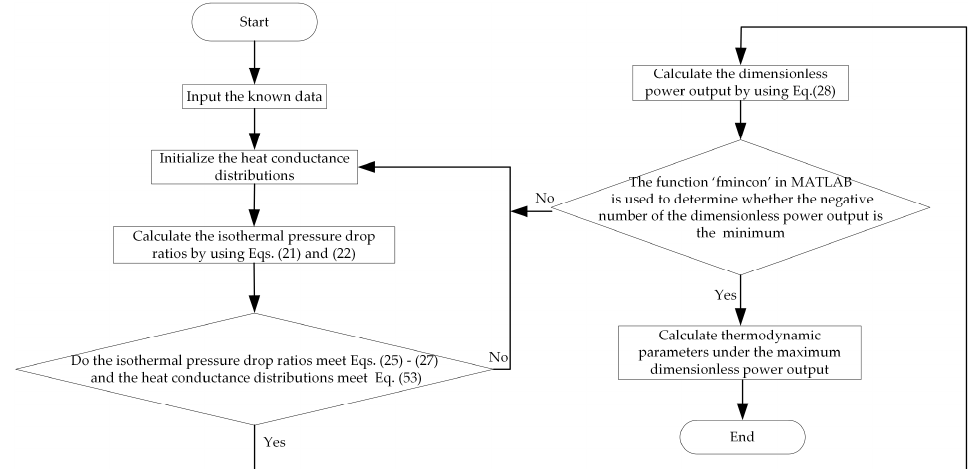
Energies 2020 , 13 x FOR PEER REVIEW 10 of 21 Figure 2. Flow chart of dimensionless power output (PO) optimization. Figure 2. Flow chart of dimensionless power output (PO) optimization. When Figure 3a,b, Figure 4a,b, Figure 5a,b and Figure 6 illustrate the relationships of the maximum dimensionless PO ( W max ), the corresponding dimensionless PO ( W top ) of the topping cycle, W max dimensionless PO ( W bot ) of the bottoming cycle, TEF η , isothermal pressure drop ratios W max W max ( ( π t ) and ( π ta ) ) and HCDs ( ( u H 1 ) , ( u H 2 ) , ( u L 1 ) , ( u L 2 ) , ( u R 1 ) , ( u R 2 ) W max W max W max W max W max W max W max W max and ( u R 2 ) ) versus the pressure ratios ( π com1 and π com2 ) in the Com1 and Com2, respectively. W max